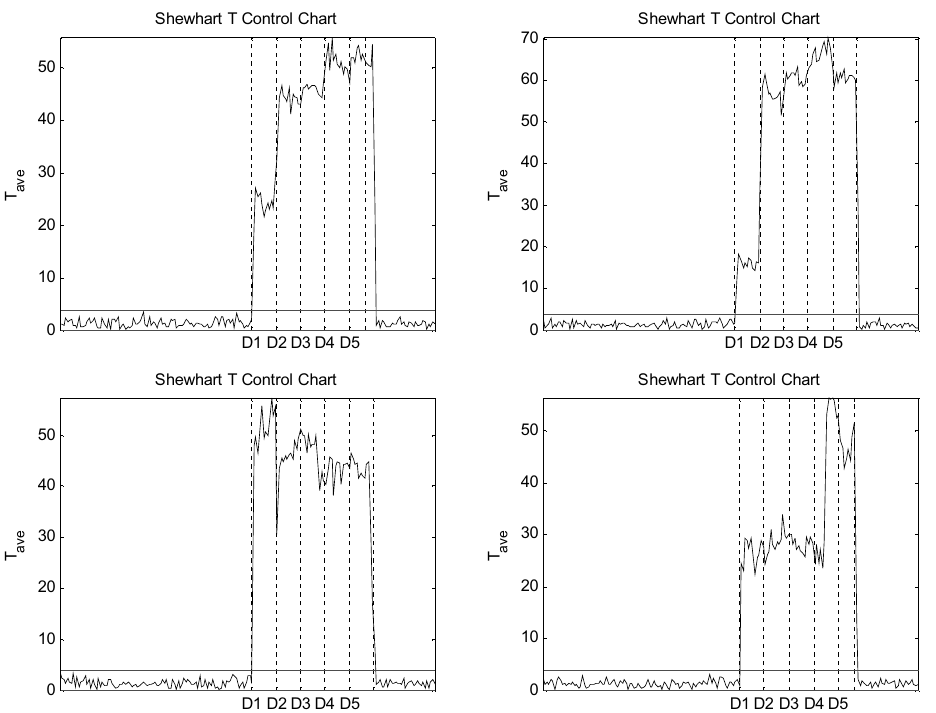
Fig. 9. Control charts for complex transmissibilities. Top left: damage location 1, 32 spectral lines. Top right: damage location 1, 64 spectral lines. Bottom left: damage location 2, 64 spectral lines. Bottom right: damage location 3, 64 spectral